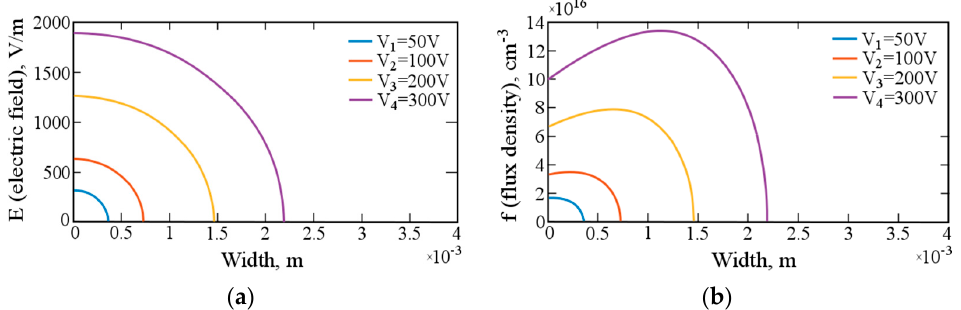
Figure 5. ( a ) Change in the electric field during the drift of lithium-ions at different applied voltages. ( b ) Change in the flux density of lithium-ions in the crystal volume at different applied voltages.